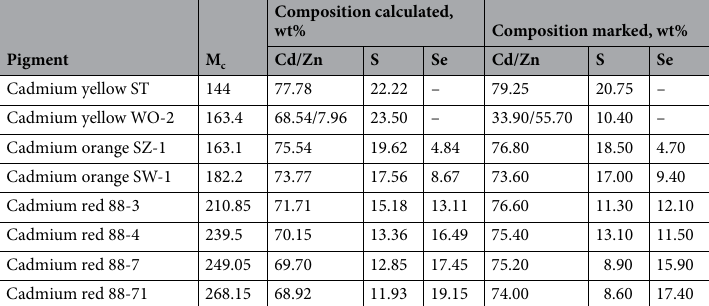
Table 2. Contents of elements in cadmium pigments.